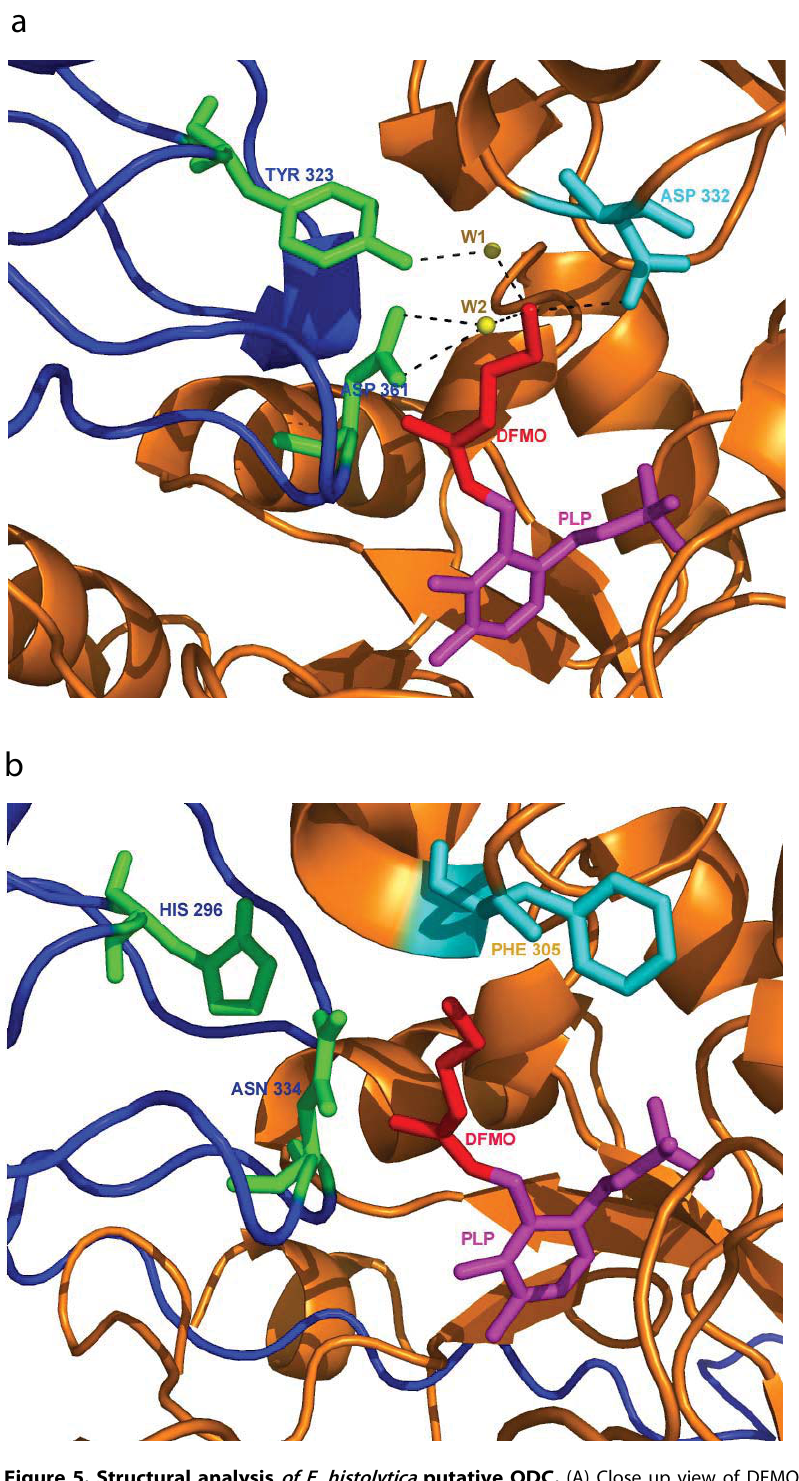
Figure 5. Structural analysis ofE.histolytica putative ODC. (A) Close up view of DFMO (red) and PLP (magenta) binding sites in the crystal structure of T. brucei ODC. The two chains of T. brucei ODC are shown in blue and orange. Positions of two water molecules are labeled W1 and W2. Hydrogen bonding is shown in dashed lines. Distances are represented in angstroms (N- e -of DFMO with W1 : 2.70 A˚; W1 with Tyr : 2.75 A˚; N- e -of DFMO with Asp-332 : 2.89 A˚; N- e -of DFMO with W2 : 3.15 A˚; W2 with OD2 of Asp 361: 2.99 A˚; W2 with OD1 of Asp-361: 2.89 A˚) (B) Close-up view of DFMO and PLP binding sites in the modeled structure of E. histolytica putative ODC. The color coding is same as mentioned in Figure 5A. The modeled structure was generated using the program MODELLER. The distance between N- e of DFMO and Asn-334 is more than 3.5A˚. Note that the structure with DFMO bound is a deliberate generation of a model corresponding to an unrealistic situation. This figure has been generated using PyMOL [47].